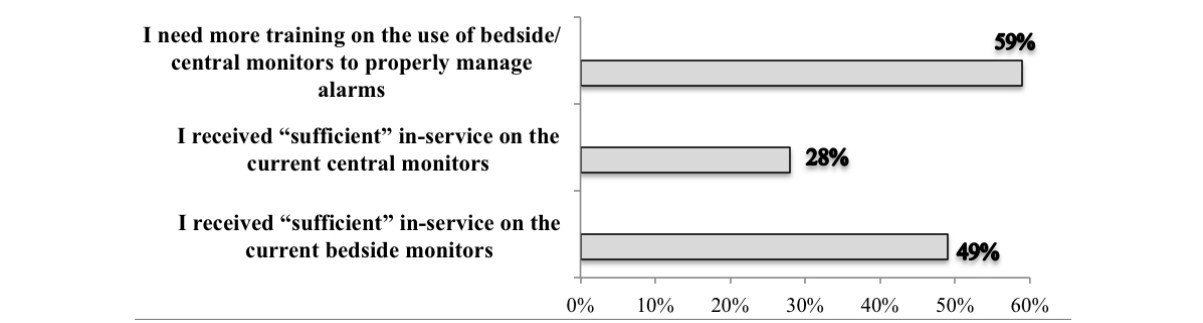
Figure 1. Percentages of TCICU nurses who agreed/strongly agreed on the adequacy of the training received on bedside and central cardiac monitors